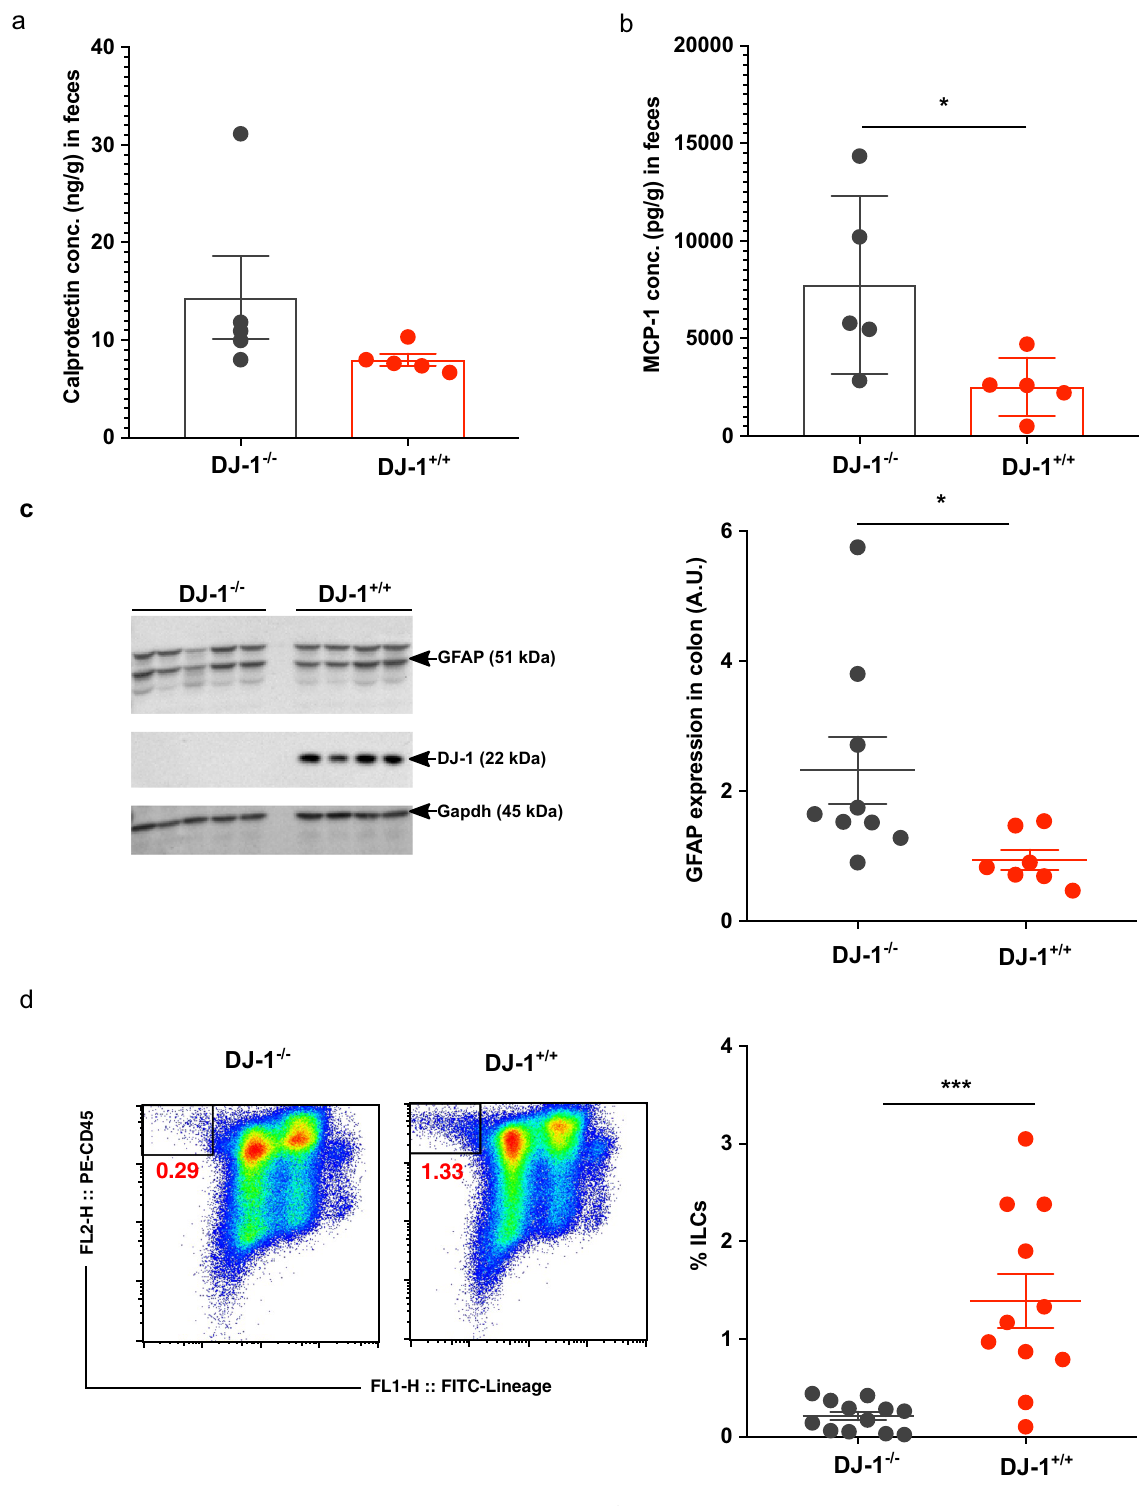
Figure 3. Increased inflammation and decreased ILCs in DJ-1 −/− mice. (a) Calprotectin level (mean ± SEM) measured by ELISA in DJ-1 +/+ and DJ-1 −/− mice fecal samples (n = 5). (b) DJ-1 −/− mice have significantly higher production of the MCP-1 (mean ± SEM) cytokine measurement from the feces. * represents the p value of < 0.05 using Student’s unpaired t-test. (c) Original Immunoblots from GFAP/Gapdh expression and quantification of the protein expression. Images used in the manuscript were cropped from the original blots which are shown in Suppl. Figure 7 and contrast was adjusted to make the image uniform. Bar diagram (mean ± SEM) shows the statistical significantly higher expression of GFAP in the colon tissues of the DJ-1 −/− mice compared to control DJ-1 +/+ mice (n = 7–9) from two different cohorts. (d) Left hand side figure shows representative FACS plots from DJ-1 +/+ and DJ-1 −/− mice spleen samples. X-axis represents Lineage markers of lymphoid cells (CD3, CD5, CD3, CD11b, CD11c, F4/80, Gr-1, B220 or CD19, and Ter119) and y-axis represents lymphoid marker CD45. Right hand side Bar diagram (mean ± SEM) shows significantly lower in DJ-1 −/− (n = 12) compared with DJ-1 +/+ (n = 11) from three different cohorts. *represents the p value of < 0.05 using Student’s unpaired